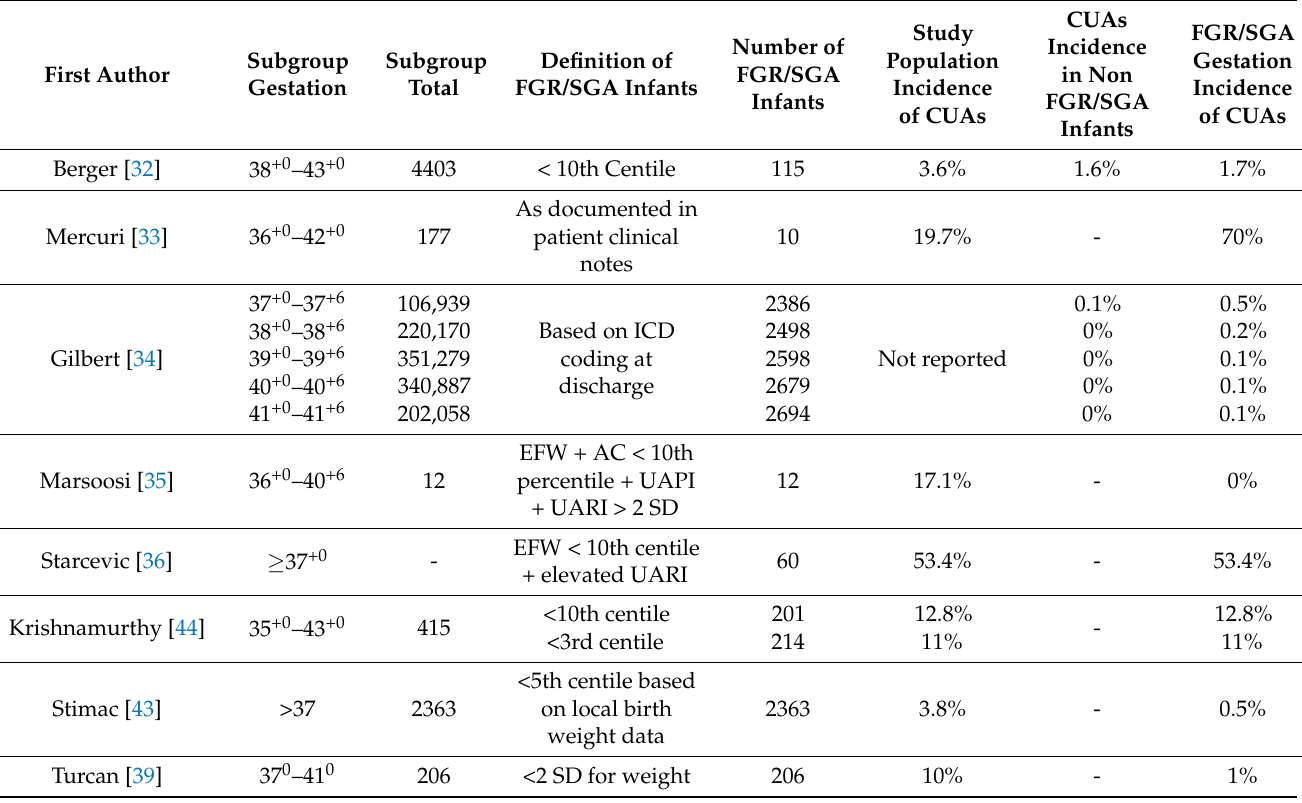
Table 7. Study Characteristics and Incidence of CUAs Reporting on Late Preterm and Term Infants.